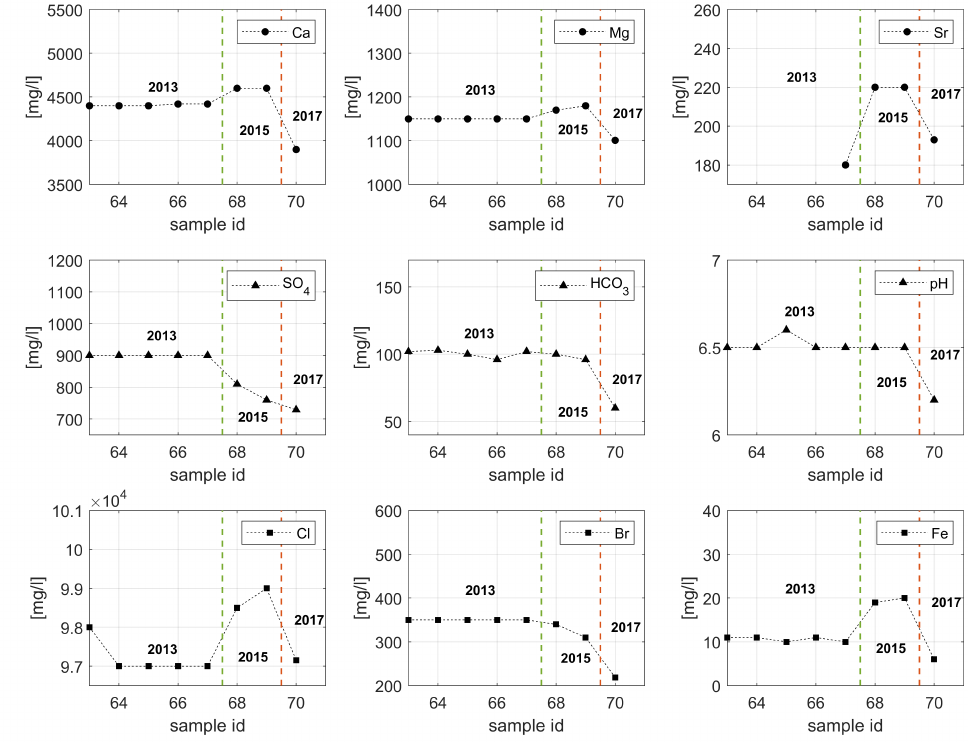
Figure 5. Chemical composition of Sønderborg brine from 2013 until 2017. Green dashed line indicates the five samples taken on 2013, red dashed line separates the samples taken on 2015 from the sample analyzed in